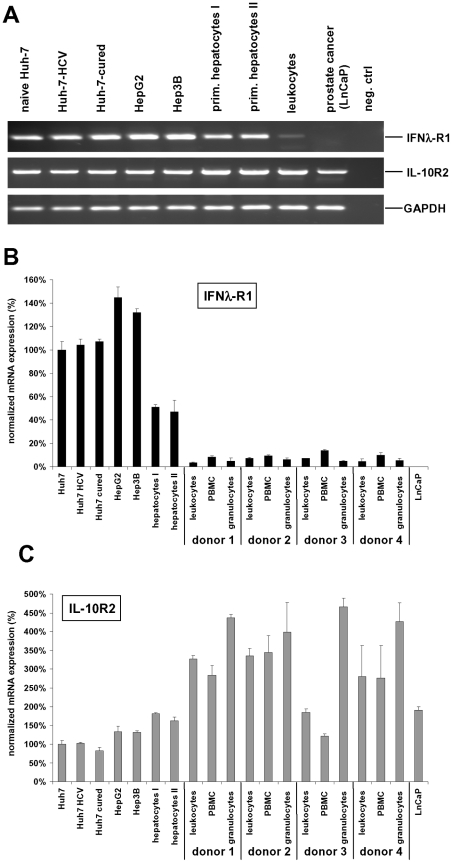
The IFN-λ receptor complex consisting of IL-10R2 and IFNλ-R1 is expressed in hepatic cell lines.(A) Expression of IL-10R2 and IFNλ-R1 in various hepatic cell lines, primary hepatocytes from two different donors and primary leukocytes were analyzed by RT-PCR analysis of mRNA derived from cells as indicated. The prostate cancer cell line LnCaP was used as a negative control for IFNλ-R1 expression. (B) Quantitative PCR analysis reveals a much lower expression of IFNλ-R1 mRNA in leukocytes from four different donors in comparison to liver cells. PBMC express twice as much IFN-λR1 than granulocytes. Expression data are normalized to Huh-7 cells. (C) IL-10R2 was expressed at higher levels in leukocytes in comparison to hepatic cells. Data are normalized to the expression in Huh-7 cells.